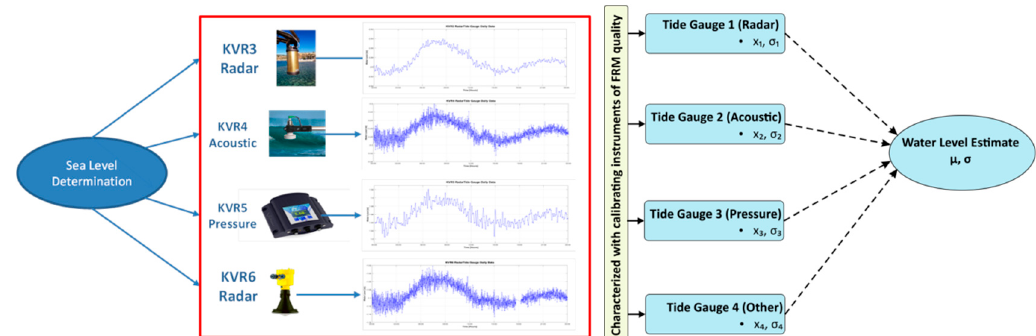
Figure 9. Water level measurements by tide gauges of diverse measuring techniques are conducted at the Gavdos sea-surface Cal/Val site. The location and scale of each independent water level record is statistically evaluated independently, and a final water level value is given after an appropriate weighting of each time